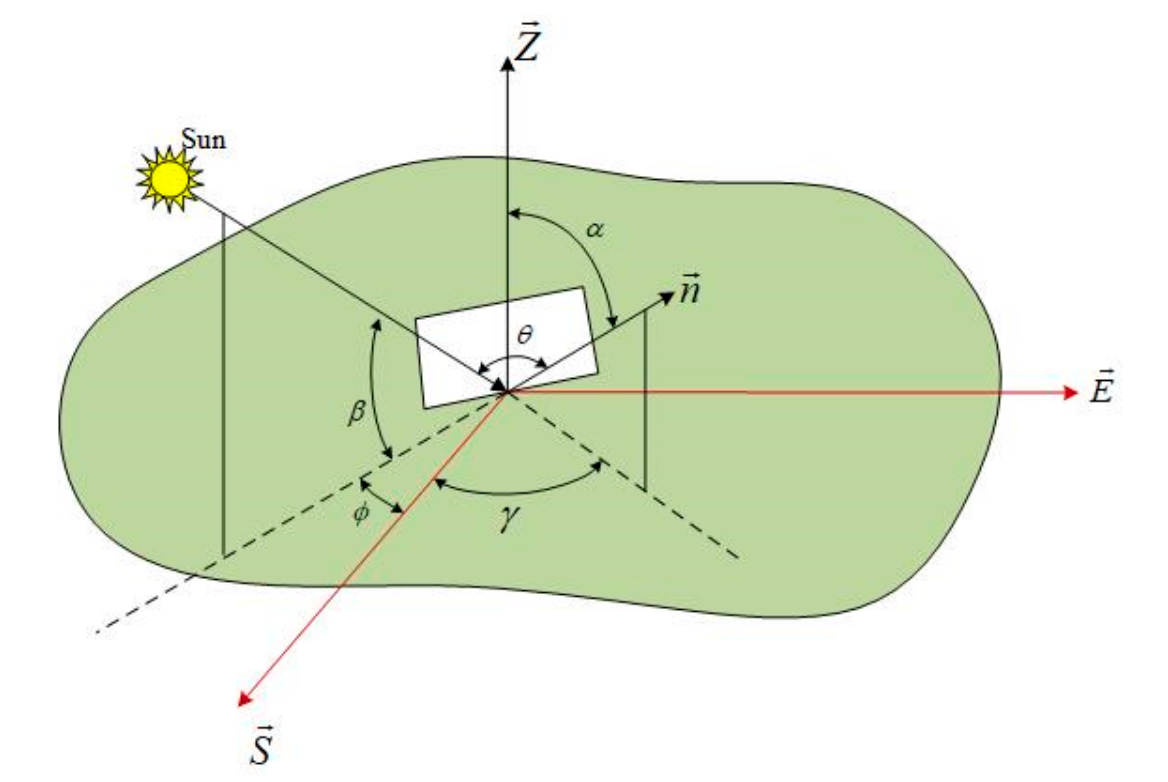
→ → S and E represent the South → → n is normal to the solar panel plane. Z denotes the Zenith